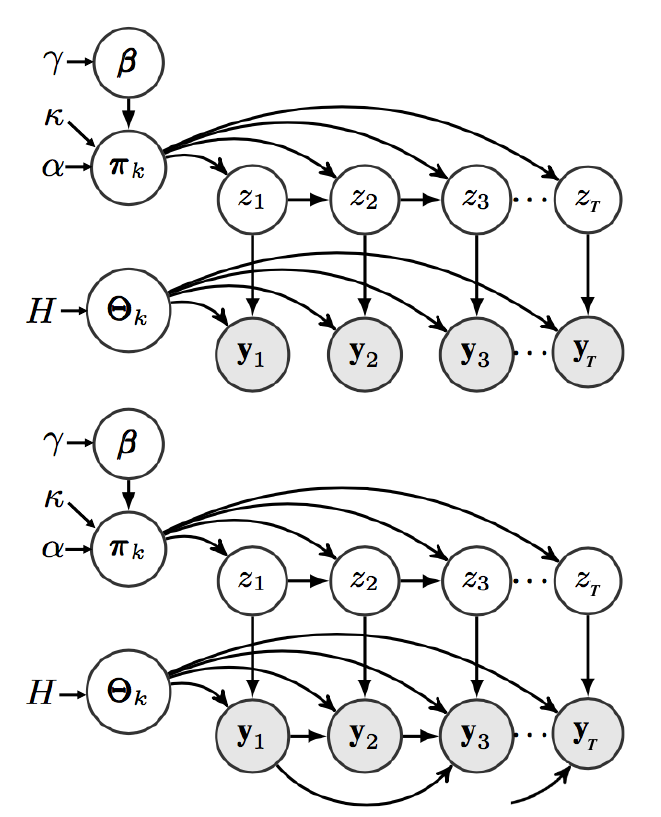
Figure 1. iHMM (top) and AR-iHMM (bottom) probabilistic graphical models. Mixing Parameters βββ are used to sample the transition distribution πππ k , which the state indicators z are sampled from. The observations y t are generated from functions with parameters ΘΘΘ z from base distribution H . The AR-iHMM differs such that there are autoregressive dependence between